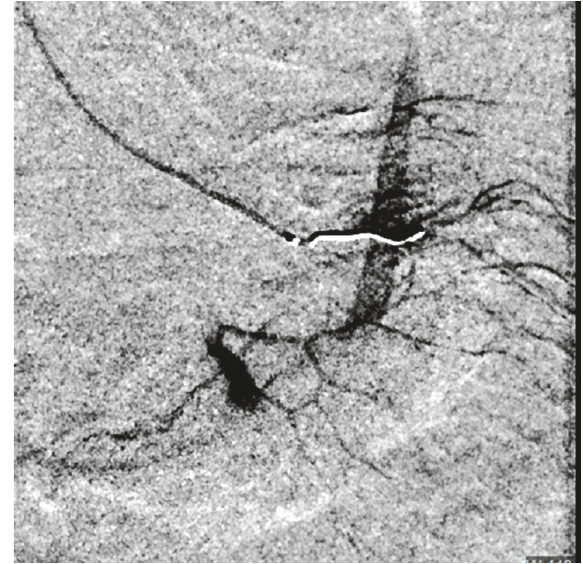
Figure 5: Angiogram showing coil insertionand continuedextrava- sation from arcade